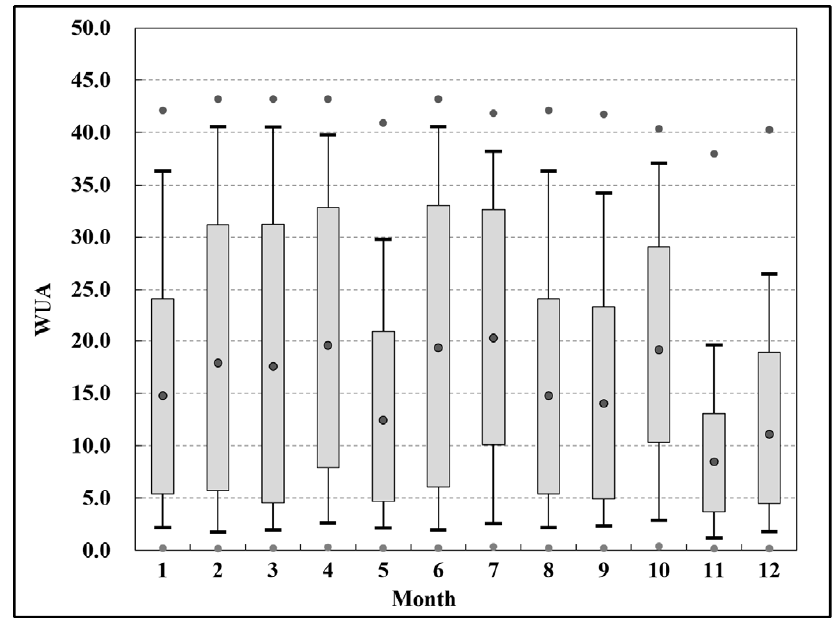
Figure 10. Box plot of WUA at squared